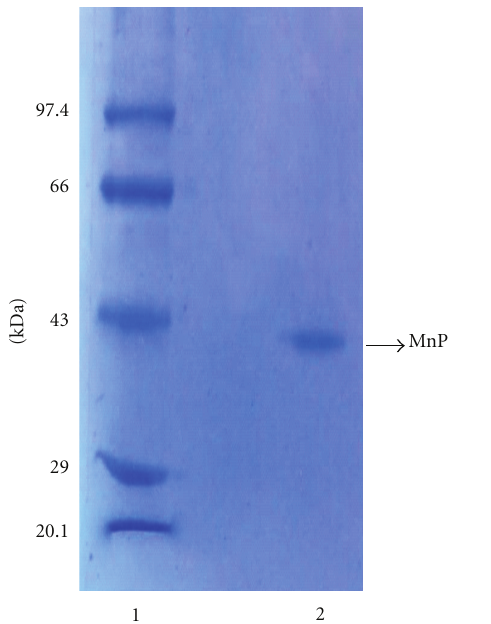
Figure 1: SDS-PAGE analysis of the purified enzyme. Lane 1: molecular weight. markers. Lane 2: purified Mn peroxidase (25 μ g).